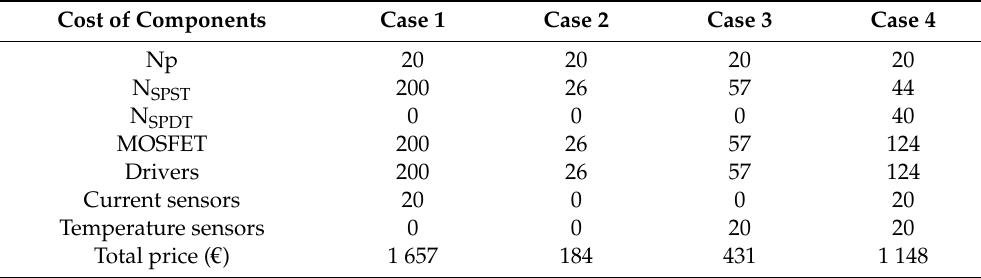
Table 4. Components considered for each